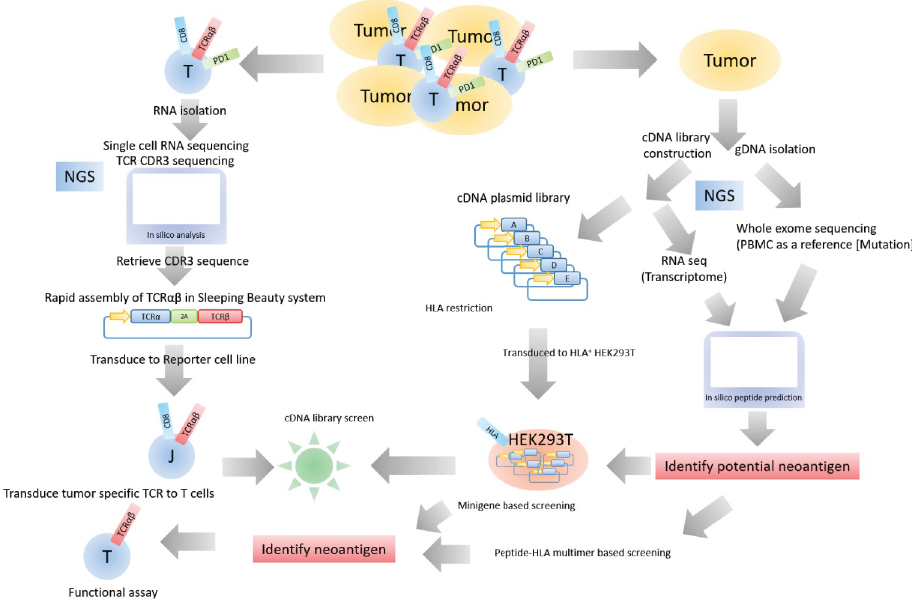
Fig 5. Potential application of the platform to identify tumor-specific TCRs and their cognate antigens.